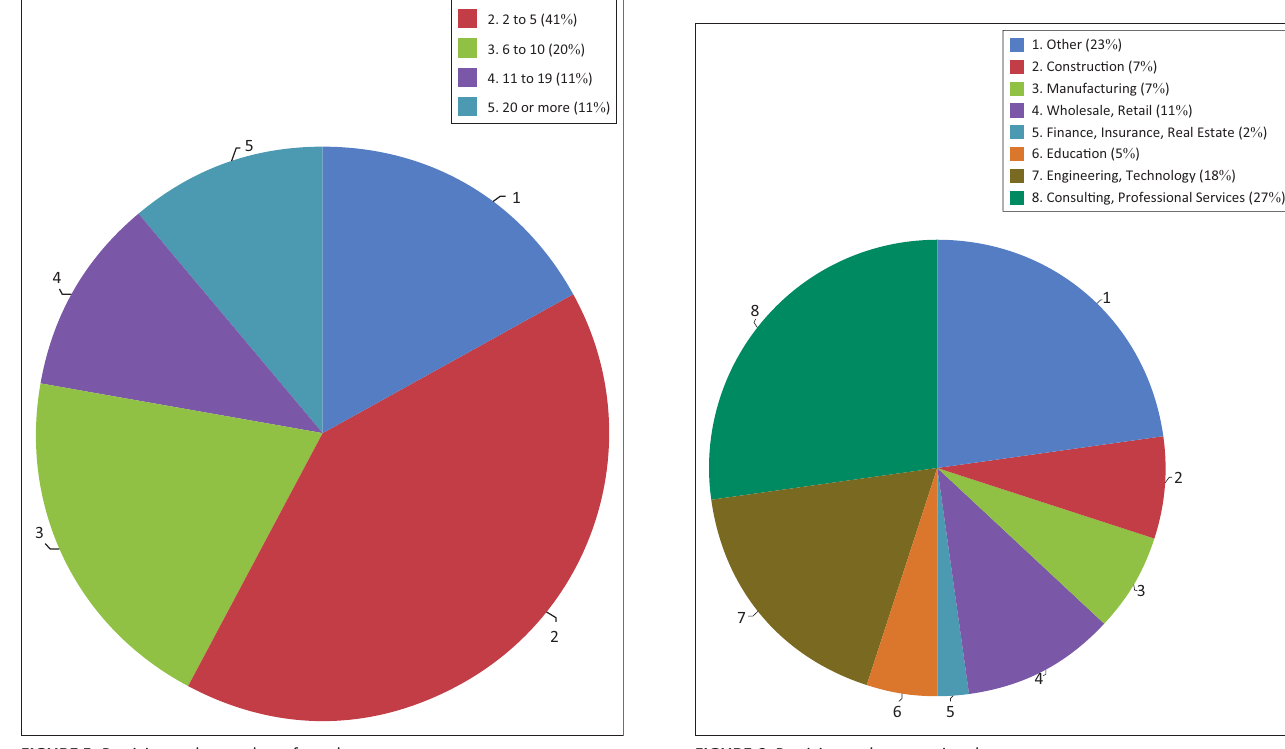
FIGURE 5: Participants by number of employees. FIGURE 6: Participants by operational